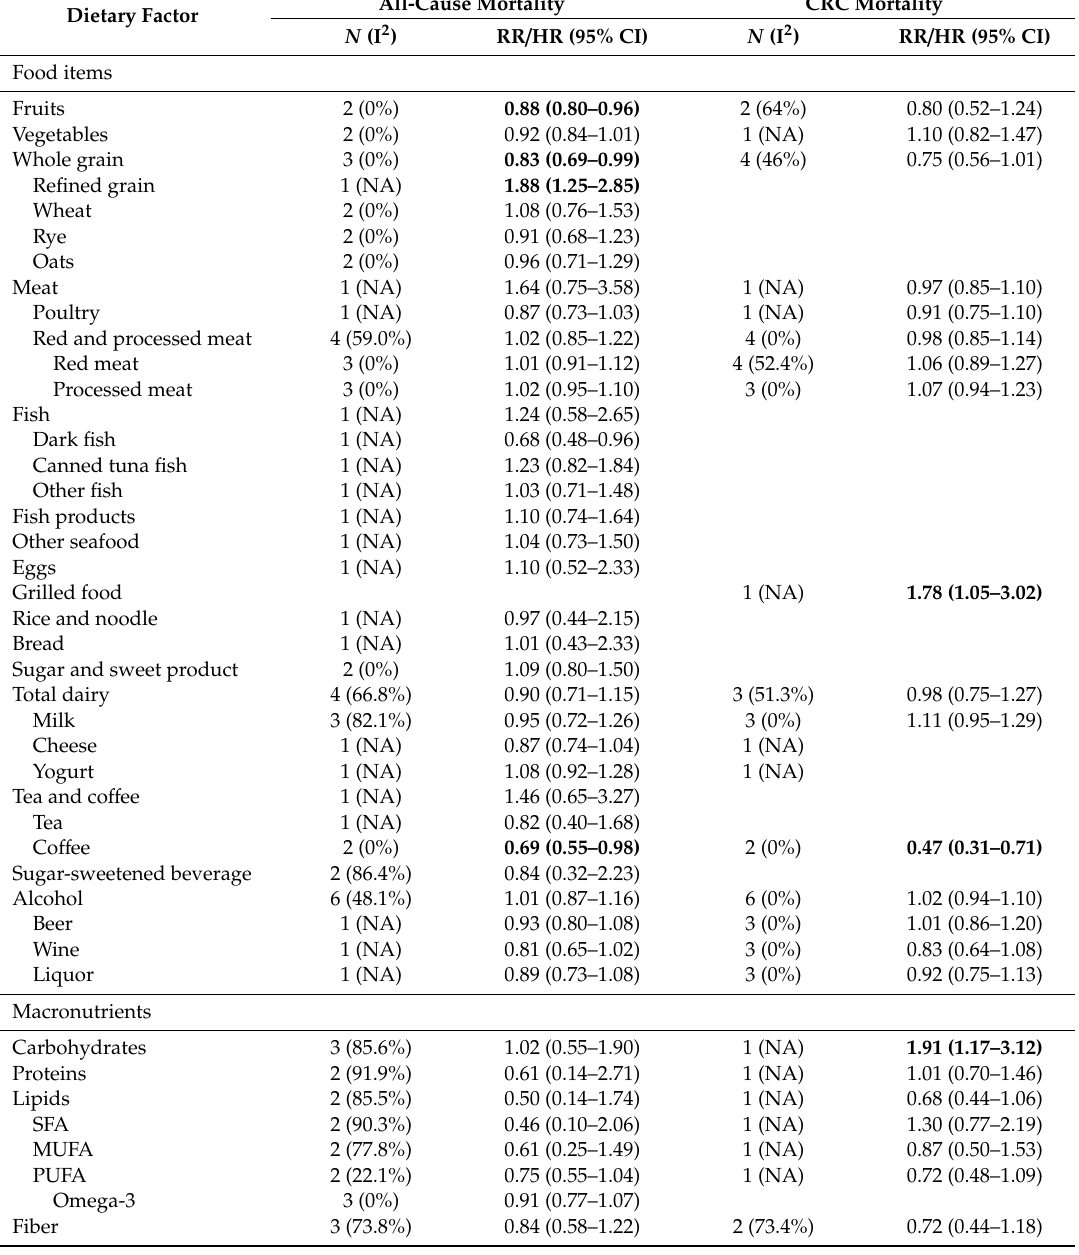
Table 1. Systematic review and meta-analysis of the associations between overall dietary intake and mortality among colorectal cancer